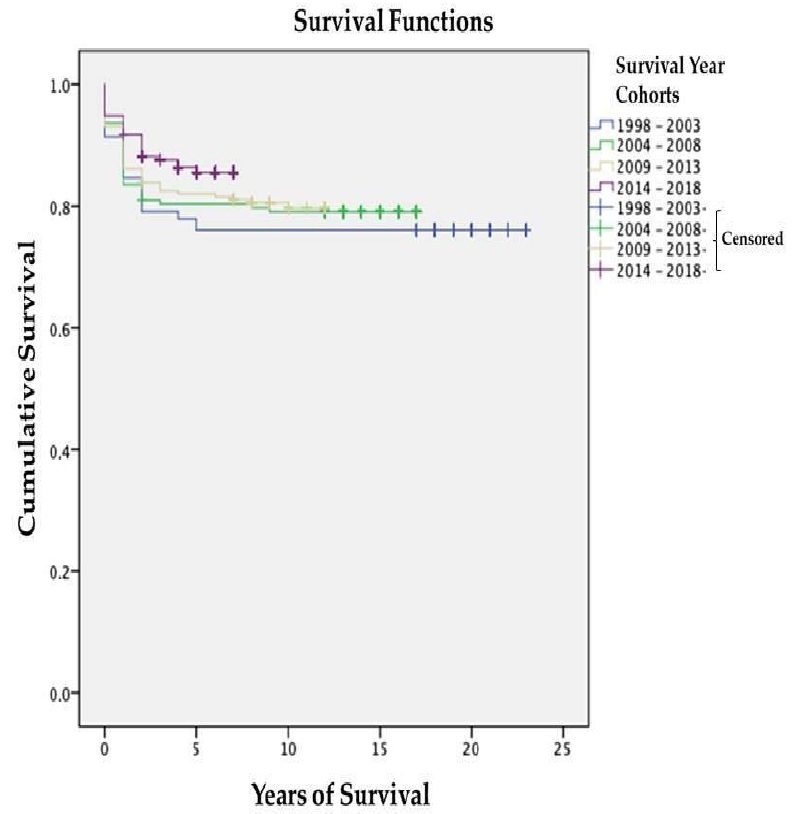
Figure 3. Childhood cancer survival across different time periods 1998–2018 (n = 733). The Cox proportional hazards regression model demonstrates that the survival rate for all childhood cancers has improved over time [log rank = 0.206].